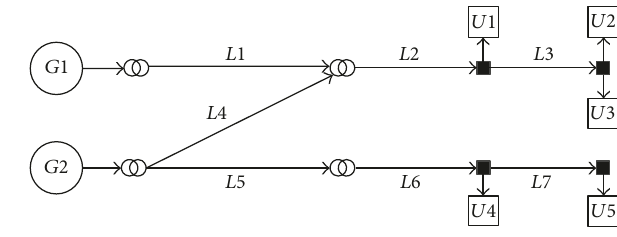
Figure 2: Topology of power grid studied.